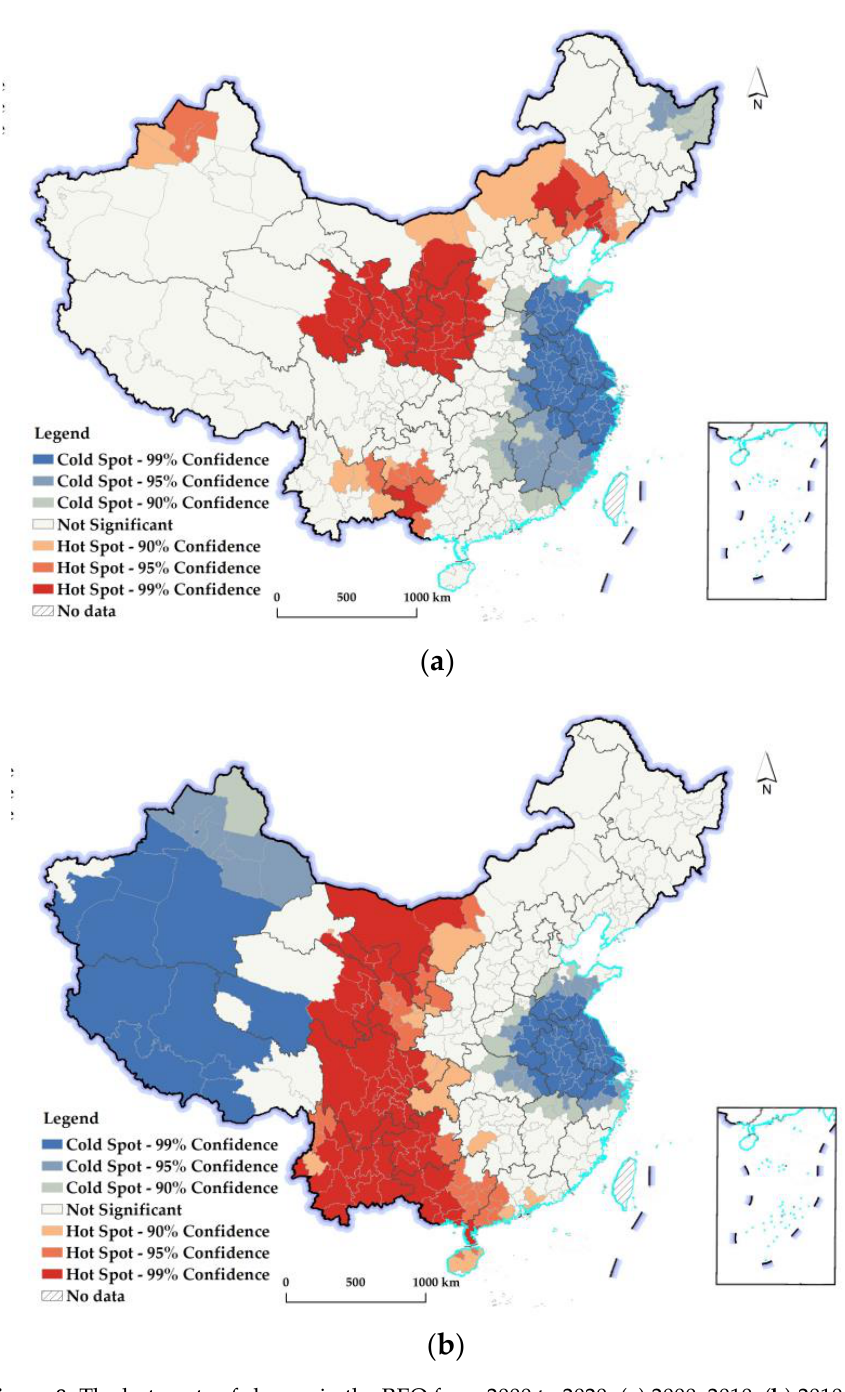
Figure 8. The hot spots of change in the REQ from 2000 to 2020. (a) 2000 – 2010; (b) 2010 – 2020. 3.3. Examining the Impacts of the Rural Population Decline on the Changes in the REQ